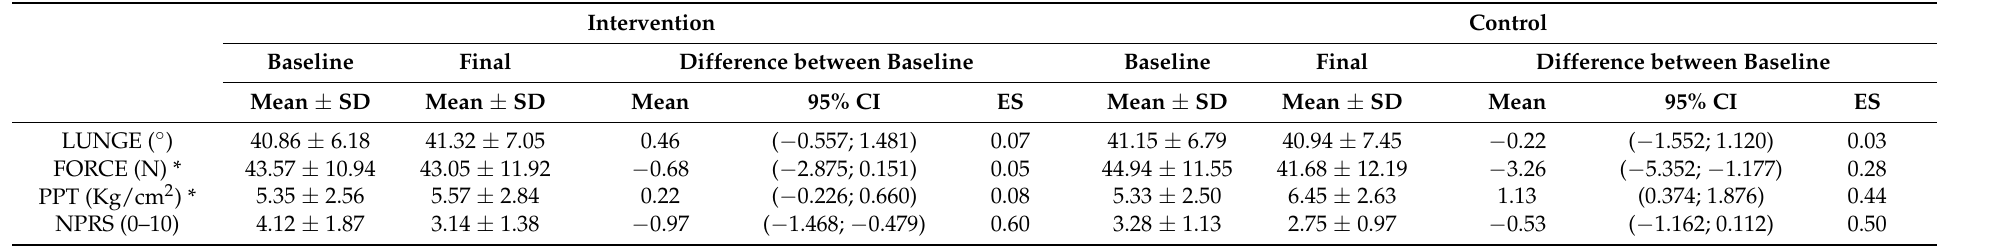
Table 2. Mean changes of the lunge test, strength, and pressure pain sensitivity in both extremities. Intervention Control